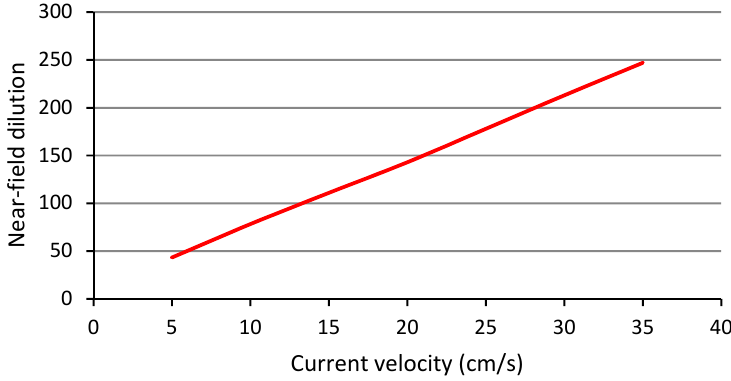
Figure 13. Effect of current velocity on near-field dilution [20].